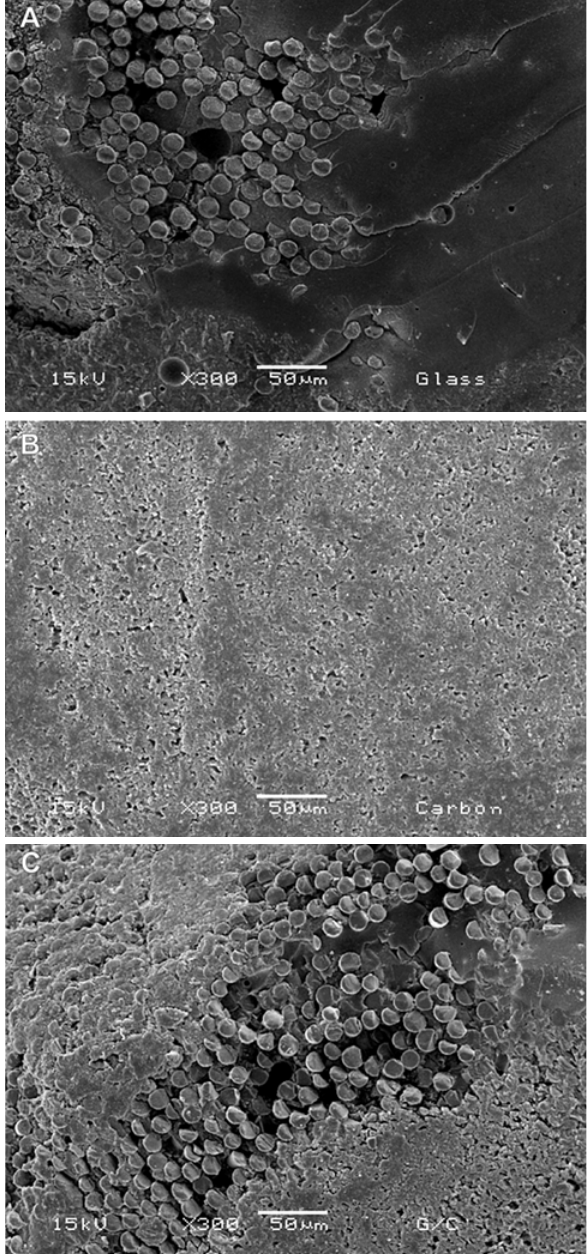
FIGURE 3- SEM micrographs for the failure modes. For the glass fiber post (A), all failures were considered mixed: note the remnants of bonding agent and luting cement on the post surface. Likewise, all failures were considered mixed for the glass/carbon fiber post (C), but the carbon fiber surfaces generally presented no remnants of adhesive or luting agent. For the carbon post (B), a predominance of adhesive failures was observed, characterized by post surface without adhesive or luting agent